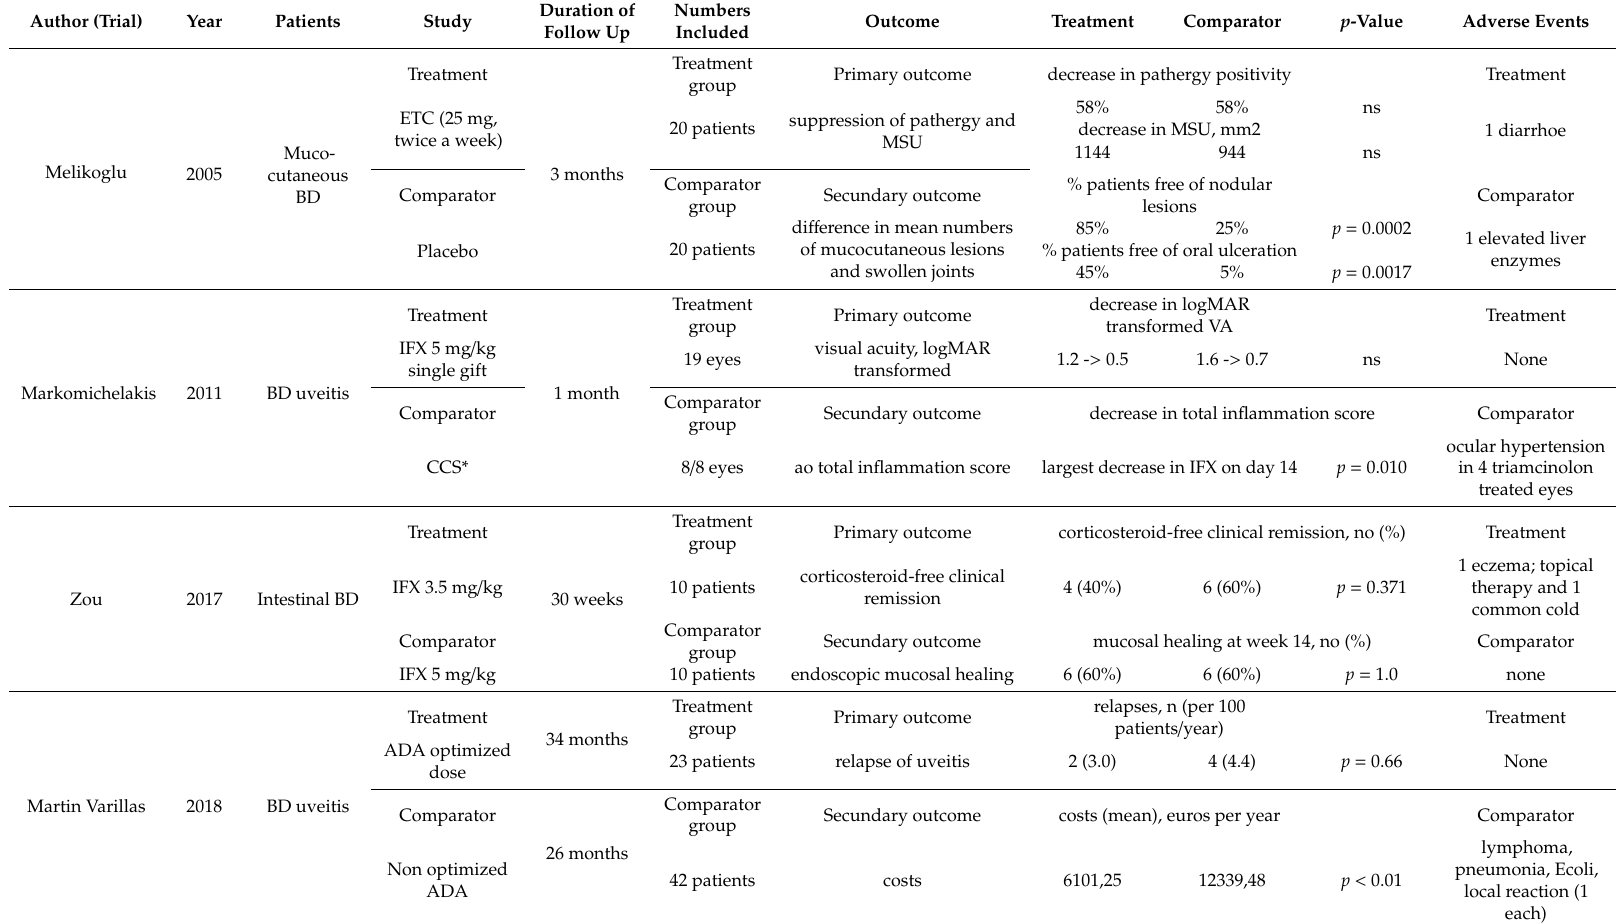
Table 1. Prospective comparative trials with anti TNF- α